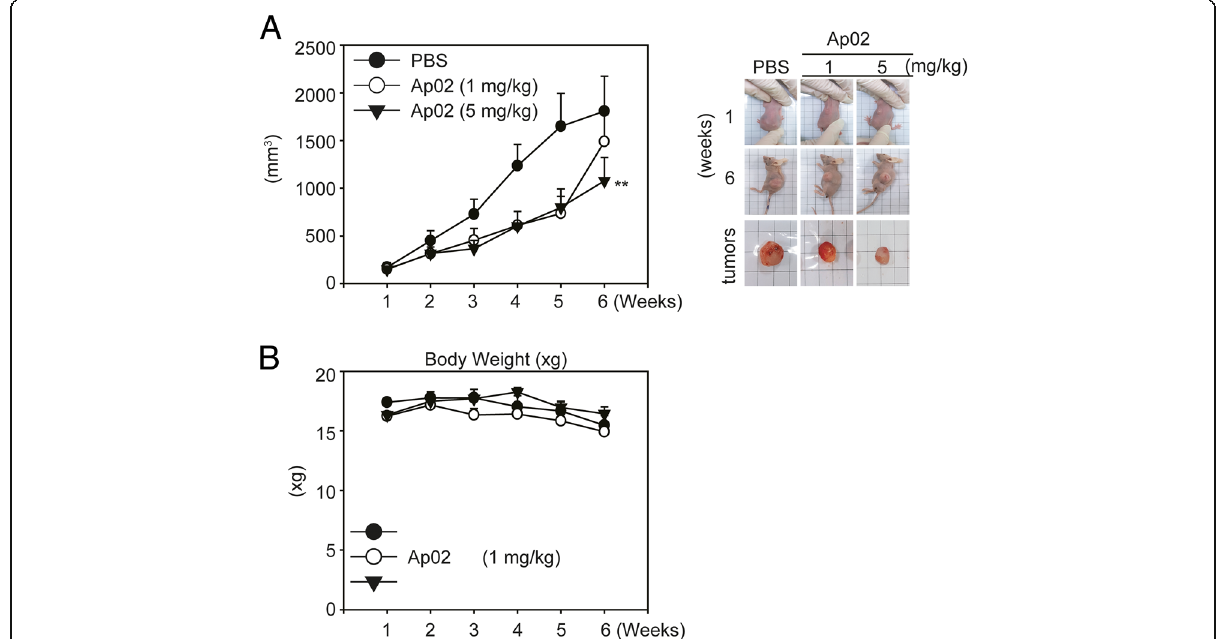
Fig. 6 Growth of COLO 205 tumor xenografts in nude mice is suppressed in response to AP-02 treatment. Athymic nude mice were injected with COLO 205 cells into interscapular subcutaneous tissue. Once tumor volume reached approximately 200 mm 3 , animals were treated with 1 or 5 mg/kg AP-02 or PBS intraperitoneally three times per week for 6 weeks. a Average tumor volume of PBS-treated (circle, n = 5) versus AP-02- treated ( n = 5) nude mice. b Body weight was measured each week during the experiment. Five samples were analyzed in each group, and values represent the means ± SE. Comparisons were subjected to Student ’ s t -test. * Significant difference at p <